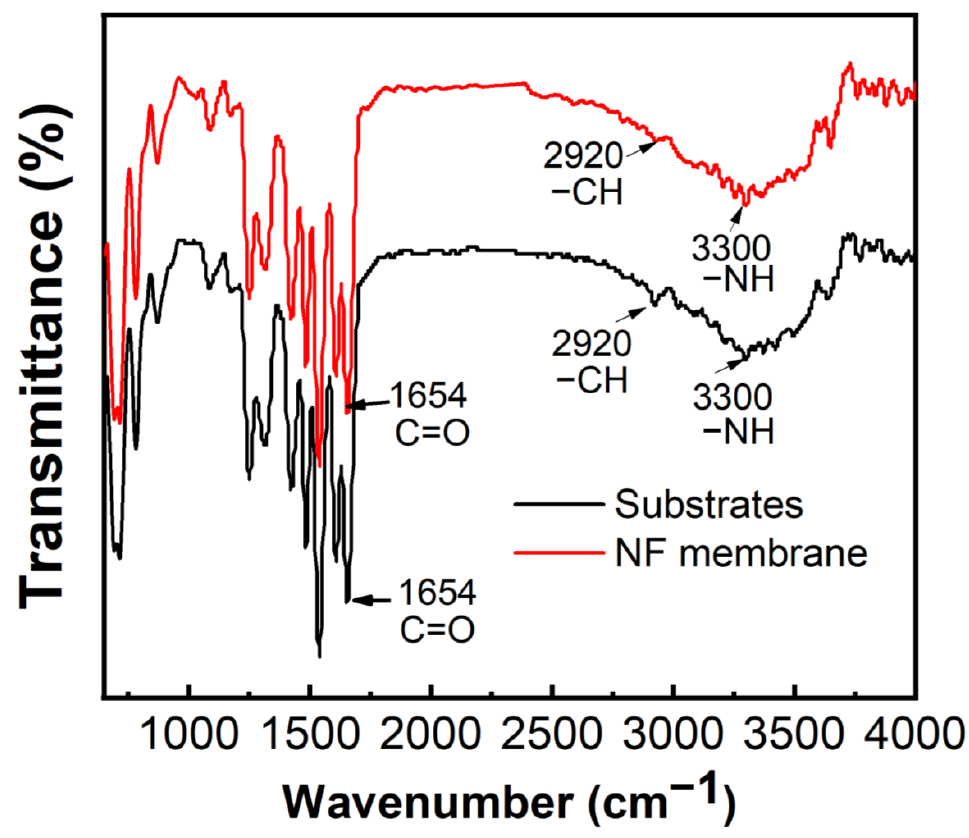
Membranes 2022 , 12 , x FOR PEER REVIEW Figure 6. FTIR spectra of PMIA substrate and PMIA TFC membrane. Figure 6. FTIR spectra of PMIA substrate and PMIA TFC membrane.